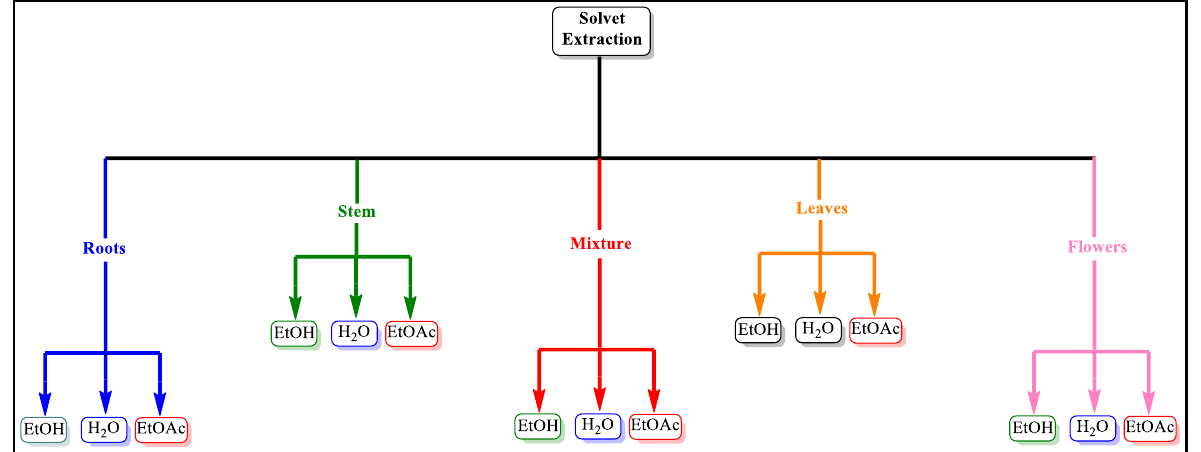
Figure 1. A schematic representation of solvent extraction using ethanol (EtOH), water (H 2 O), and ethyl acetate (EtOAc) for various plant sections and their mixtures (whole plant). A total of 15 various extracts were obtained.